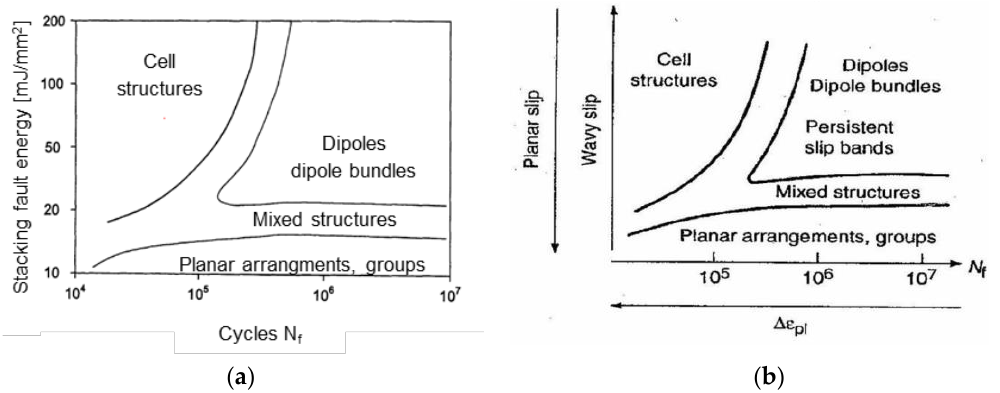
Figure 1. ( a ) Dependence of stacking fault energy on cyclic slip mode and fatigue life [3], with permission from DGM, 2019; ( b ) modified diagram proposed by Mughrabi [4], with permission from Elsevier, 2019.